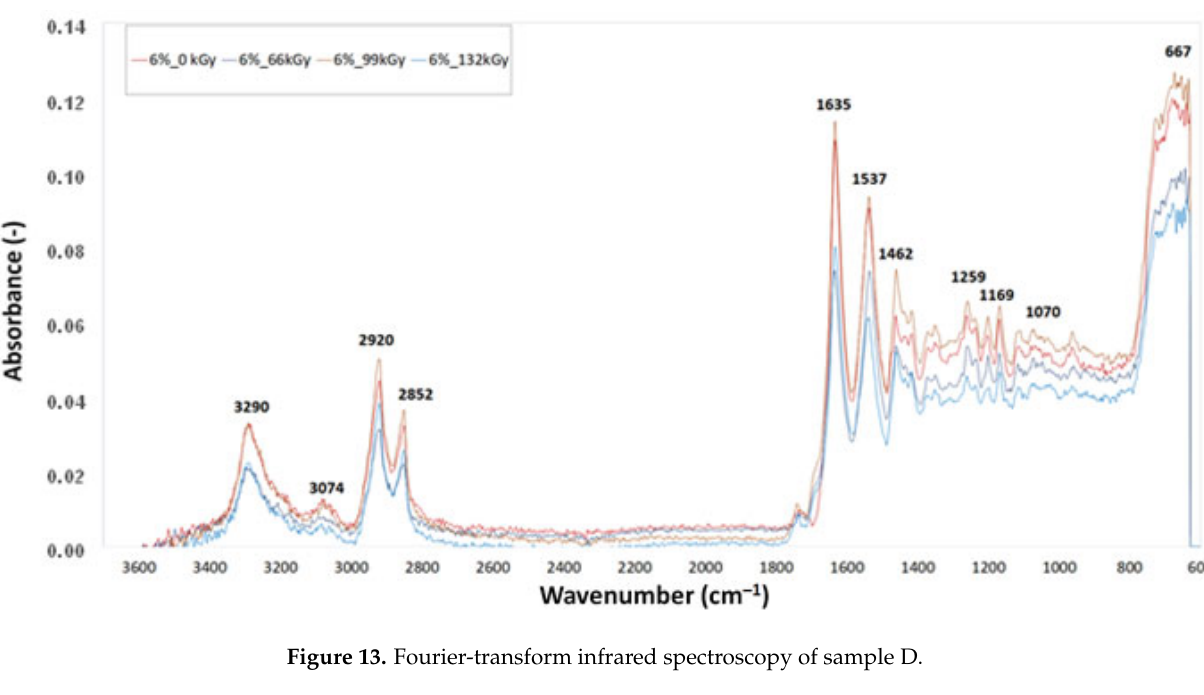
Figure 12. Fourier-transform infrared spectroscopy of sample C.